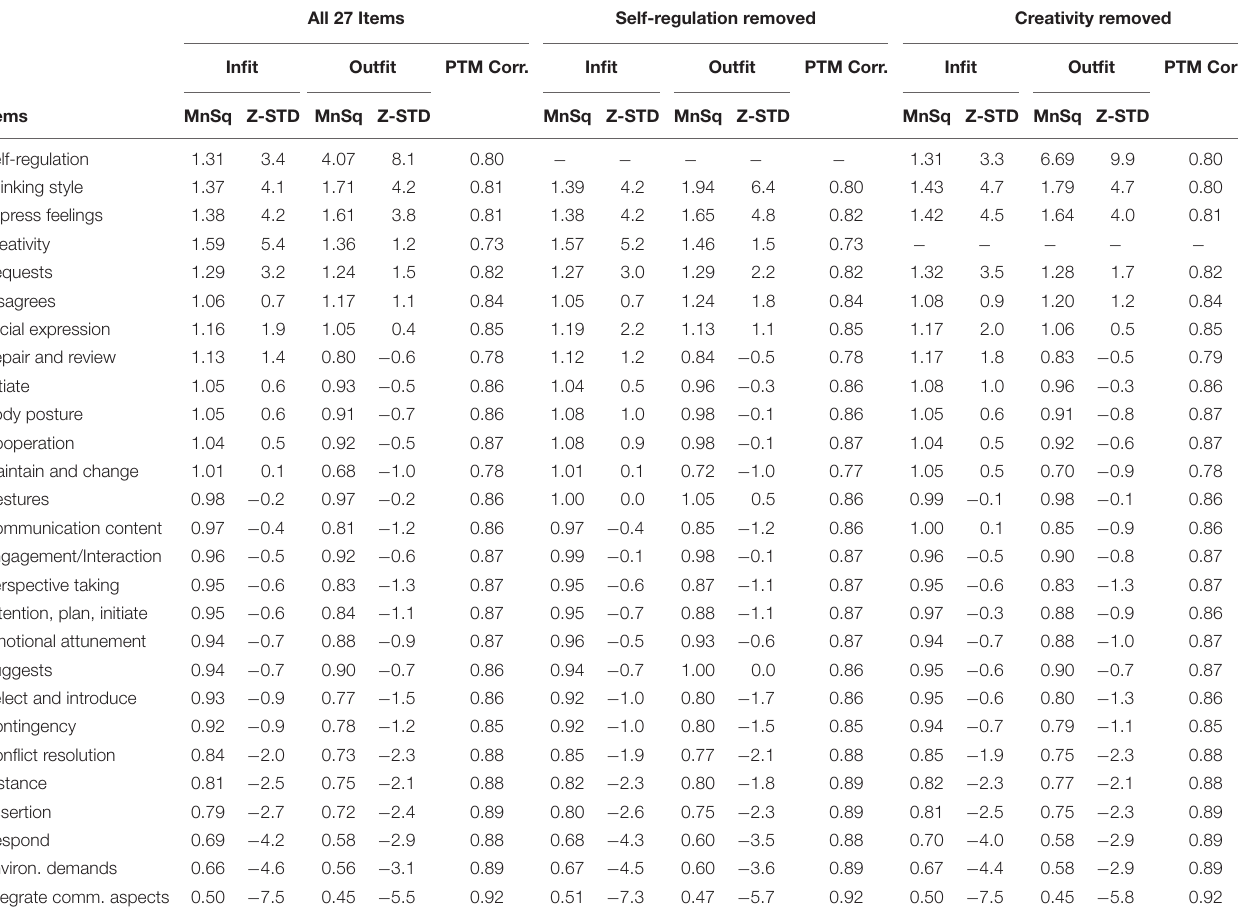
TABLE 5 | Individual item fit statistics and principal component analysis for subscales. All 27